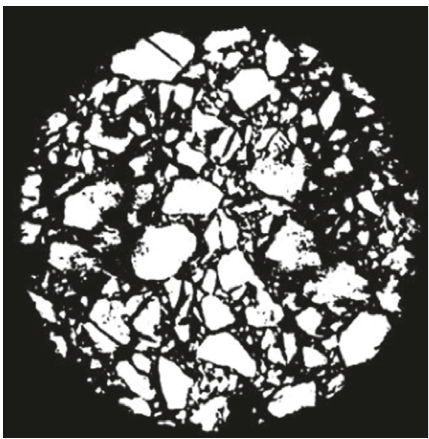
Figure 7: GMM-EM method.